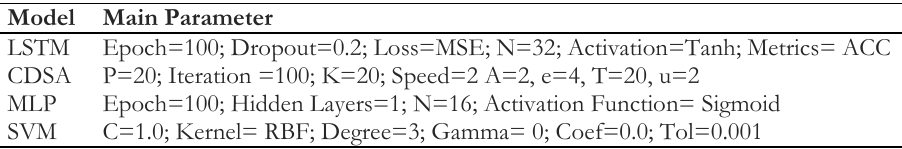
Table 2. Parameters and configuration for models.